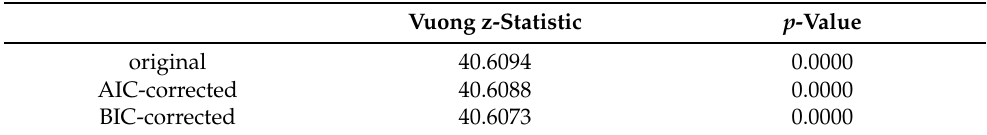
Table 4. Results of the Vuong test NB ×